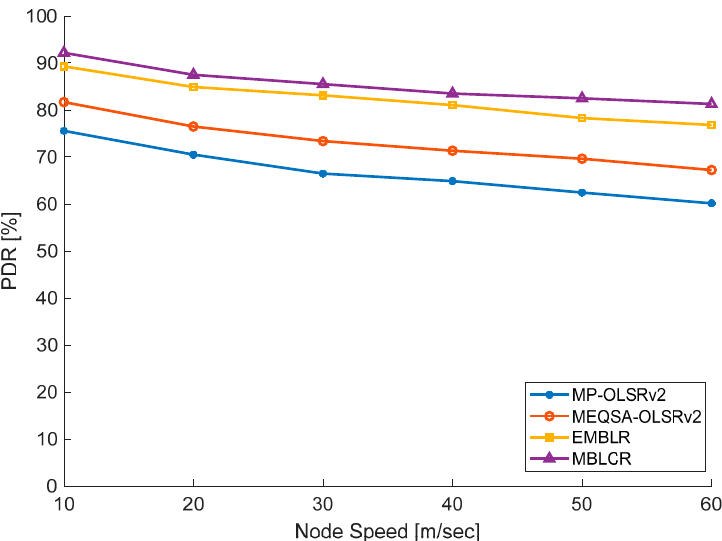
Figure 7. Packet delivery ratio with various device